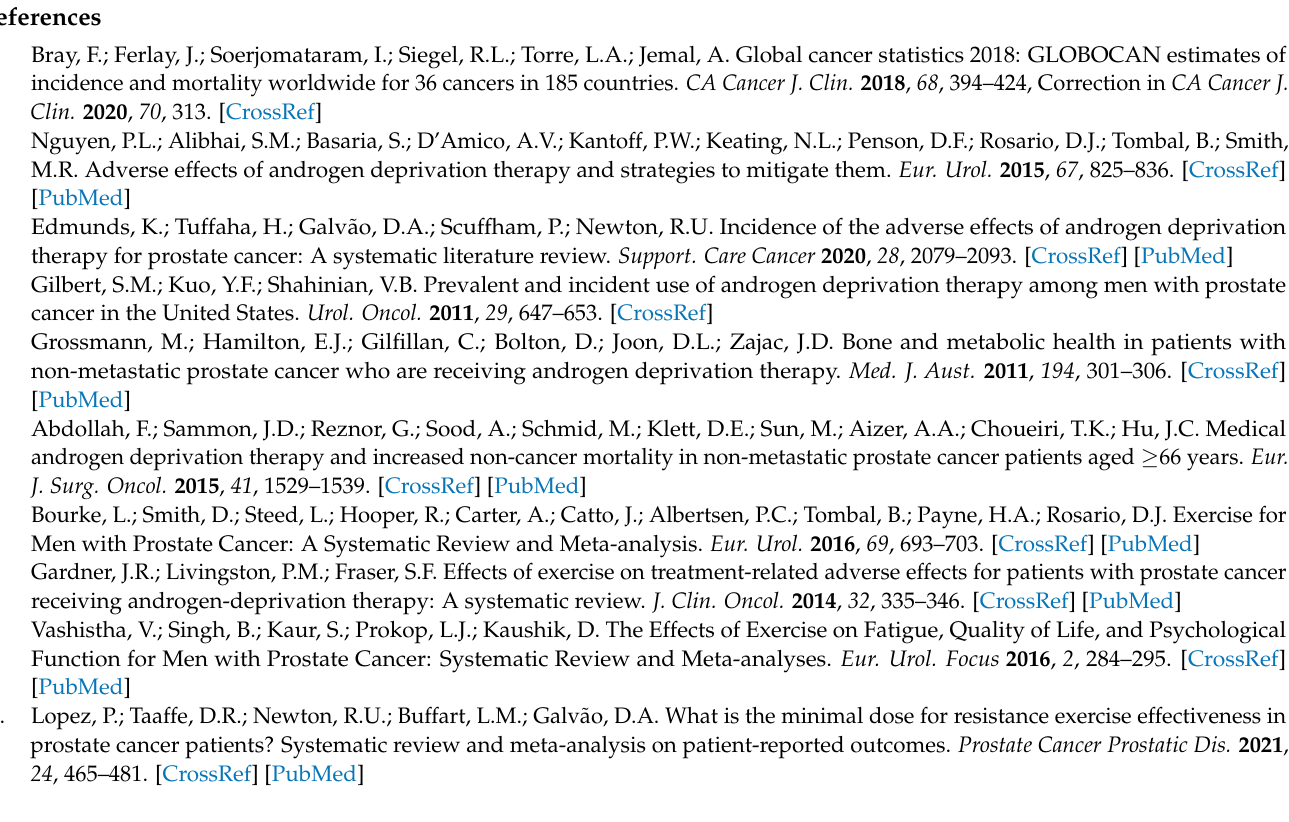
Figure S24: Pooled standard mean difference (SMD) on Systolic blood pressure comparing exercise interventions with usual care or control in men with prostate cancer. A random effects model of DerSimonian & Laird, with estimate of heterogeneity from the Mantel-Haenszel model was used, Figure S25: Pooled standard mean difference (SMD) on Systolic blood pressure comparing exercise interventions with usual care or control in men with prostate cancer stratified after exercise modality. A random effects model of DerSimonian & Laird, with estimate of heterogeneity from the Mantel- Haenszel model was used, Figure S26: Pooled standard mean difference (SMD) on Diastolic blood pressure comparing exercise interventions with usual care or control in men with prostate cancer. A random effects model of DerSimonian & Laird, with estimate of heterogeneity from the Mantel- Haenszel model was used, Figure S27: Pooled standard mean difference (SMD) on Diastolic blood pressure comparing exercise interventions with usual care or control in men with prostate cancer stratified after exercise modality. A random effects model of DerSimonian & Laird, with estimate of heterogeneity from the Mantel-Haenszel model was